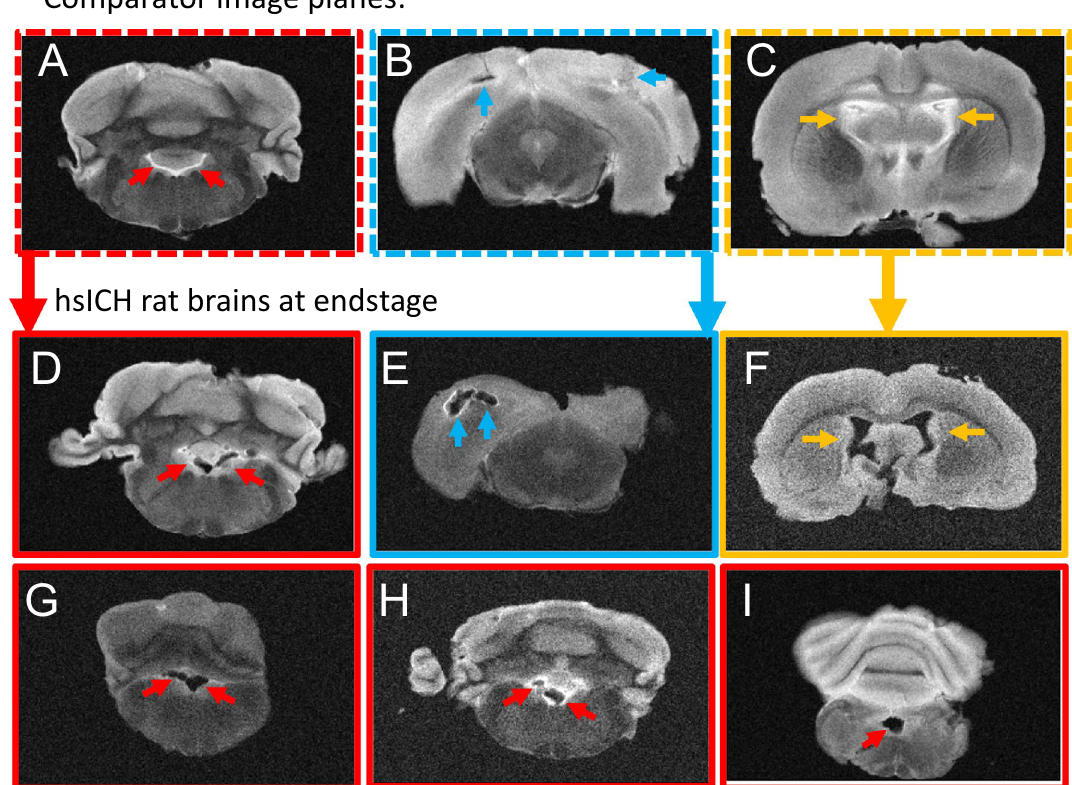
Figure 6. Ex vivo T2-weighted 9.4 T MR-images of hsICH rat brains at end-stage. ( A – C ) Representative comparator 9.4 T MR-images at the ( A ) plane of medulla with no blood in the 4th ventricle ( → ), CSF shows white on T2-W MRI; ( B ) at the plane of the midbrain showing smaller IPH and PHE; and ( C ) at the plane of CSF-filled (white) lateral ventricles ( → ) and 3rd ventricle; no IVH. ( D – I ) Representative hsICH rat brains (n = 6) obtained after sICH-death confirming sICH as cause of death showing ( D ) IVH in the 4th ventricle (red → ), ( E ) severe IPH with PHE (blue → ), ( F ) IVH in lateral and 3rd ventricles (yellow → ), ( G – I ) IVH in the 4th ventricles (red → ). Panels ( A – C ) show comparator MR-images for Panels ( D – I ) as marked and outlined per